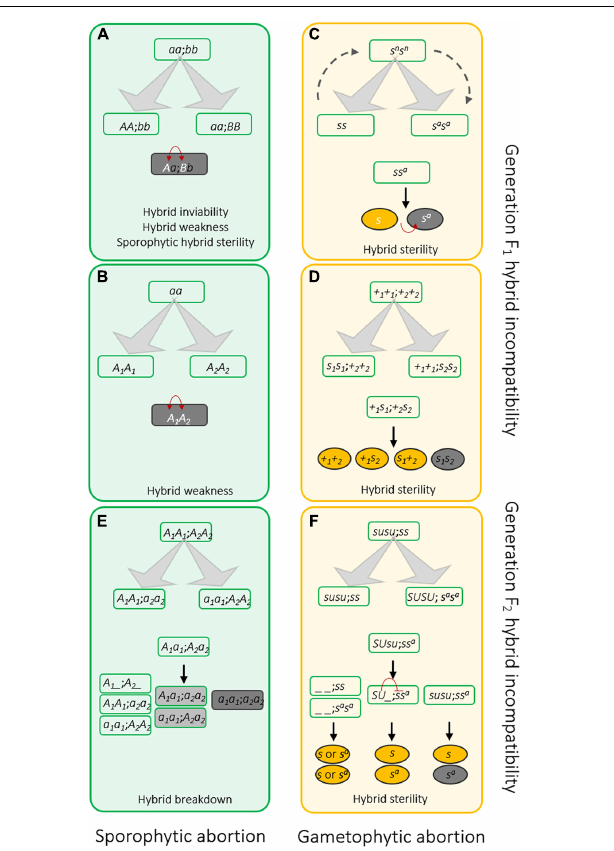
FIGURE 2 | Genetic models of hybrid incompatibilities that occur in sporophytes (A,B,E) and gametophytes (C,D,F) at F 1 generation (A–D) or later generation (E,F). (A) Classic two-locus interaction Bateson-Dobzhansky–Muller (BDM) model. Ancestral genes were independently mutated and sustained in parallel populations isolated by geographic barrier. The mutations are compatible to their own genetic contexts. However, mixture of these mutations are deleterious to the hybrids and leads to hybrid incompatibility. (B) The allelic interaction BDM model. Distinct from the two-locus involved BDM model, disharmonious interaction occurs between different alleles at one locus. (C) The sporo-gametophytic interaction model. Allelic interaction cause gamete abortion in the hybrids. The selfish nature of S allele can kill gametes with genotype S a . The S and S a alleles are likely evolved from a wild-compatible allele S n , which is compatible with either S and S a . No fertility issue can be observed in SS n and S a S n hybrids. Alternatively, S n allele may also be the intermediate form of S and S a during evolution. For example, after the ancestral allele S mutating to S n , a second mutation of S n produces S a . (D) The duplicate gametic lethal model. At least one functional copy of the duplicated loci of S1 and S2 is required for gamete development. To avoid confusing of s 1 and s 2 , the functional alleles ( S 1 and S 2 ) are illustrated as + 1 and + 2 in the figure. (E) The duplicate recessive lethal model to elucidate genetic control of sporophytic F 2 hybrid dysfunction. Duplicated A 1 and A 2 are essential to plants. Mutation at one locus is tolerated in plants due to the redundancy. However, if two populations carry mutations at different loci, their offspring with genotype a 1 a 1 a 2 a 2 will show inferiority, owing to lack of any functional copy of A 1 or A 2 . (F) A more complicated genetic model controlling F 2 hybrid sterility identified in rice. During evolution, a regulator Su was evolved to suppress the selfish nature of the S allele described in (C) in a sporophytic manner. Only the ss a hybrids without SU showed sterility. The red arrows in (A–C) indicate deleterious genetic interactions between loci or alleles. The yellow and gray ovals in (D–F) indicate fertile and sterile pollens,